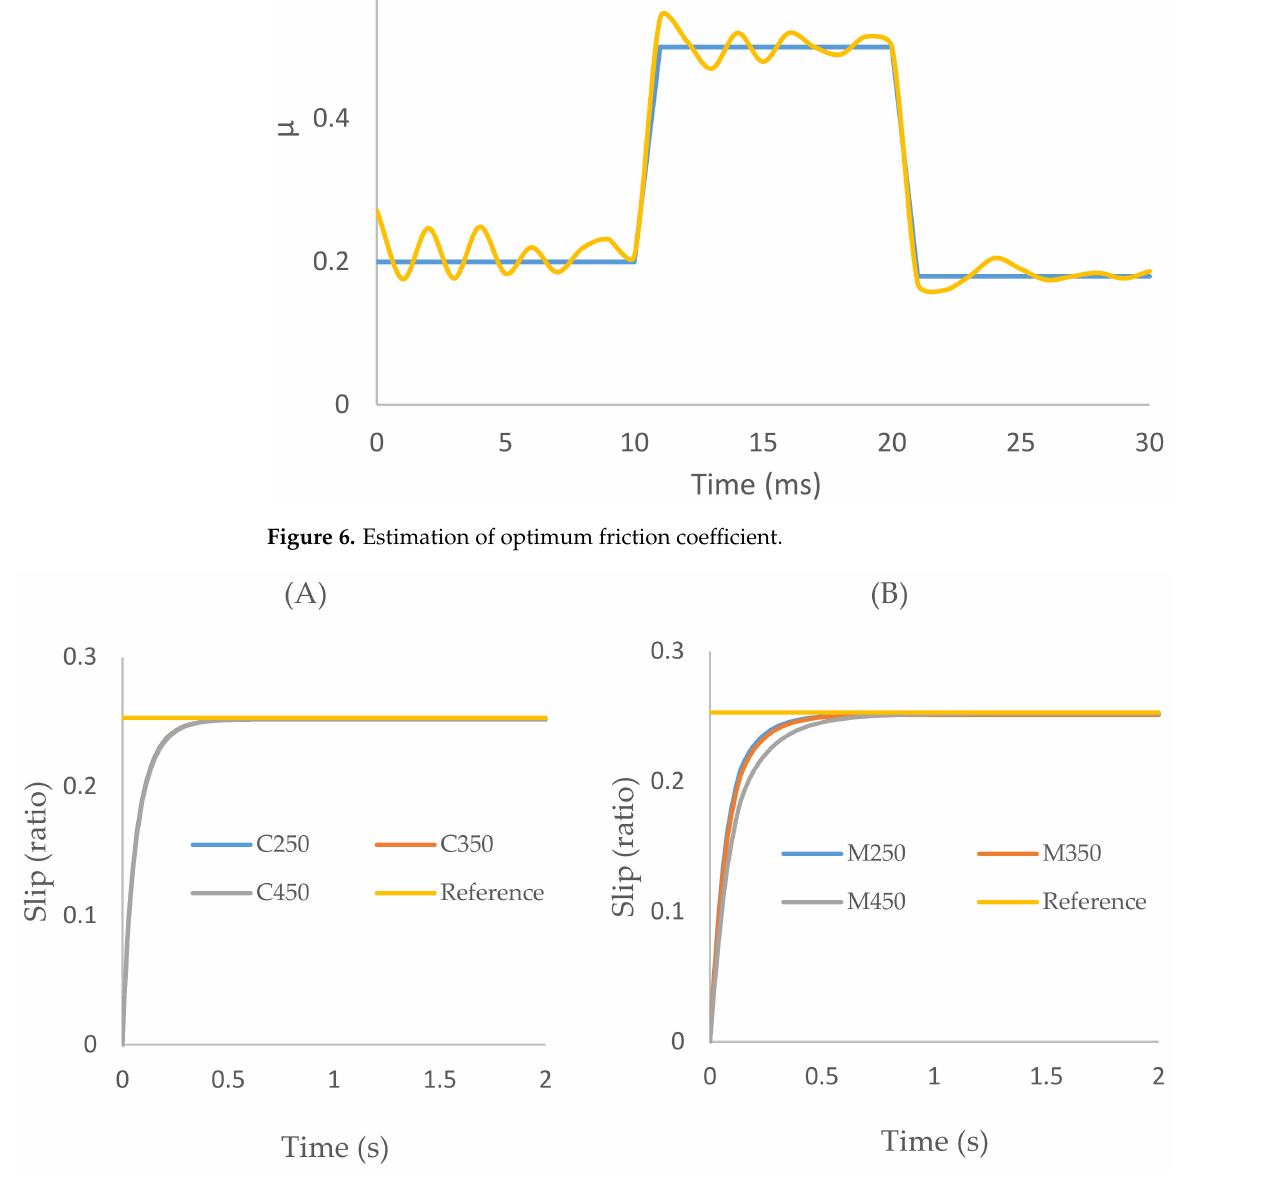
Figure 7. Controller robustness to disturbances: ( A ) RRC variations and ( B ) weight